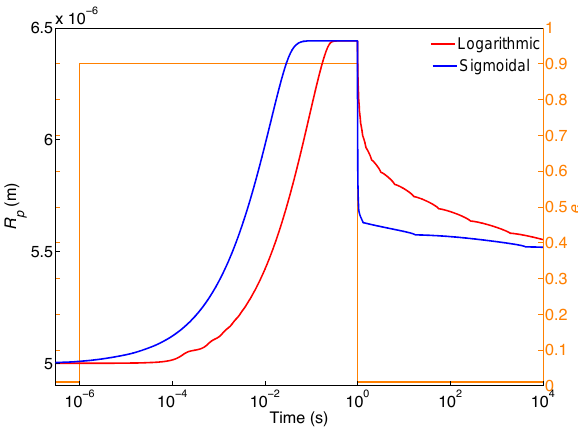
Figure 6. The radius ( R p ) change with time for a single particle subject to the changes in e s shown by the orange curve and right vertical axis. Here D 0 sv = 2 × 10 − 9 and D 0 nv = 1 × 10 − 25 m 2 s − 1 using the D i dependencies given in the